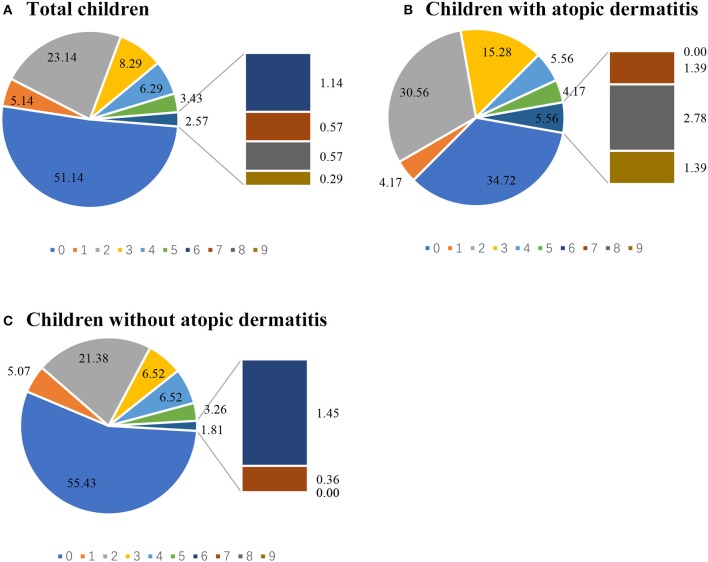
The positive number of allergic sensitization in each child was calculated. Percentages of children with particular number of allergic sensitization were analyzed in all children with skin prick test (A), children with AD and underwent skin prick test (B), and children without AD and underwent skin prick test (C) which was calculated as percentage(%)=(number of children with particular number of allergic sensitization)/(the number of children in each group who underwent the skin prick test) × 100%.